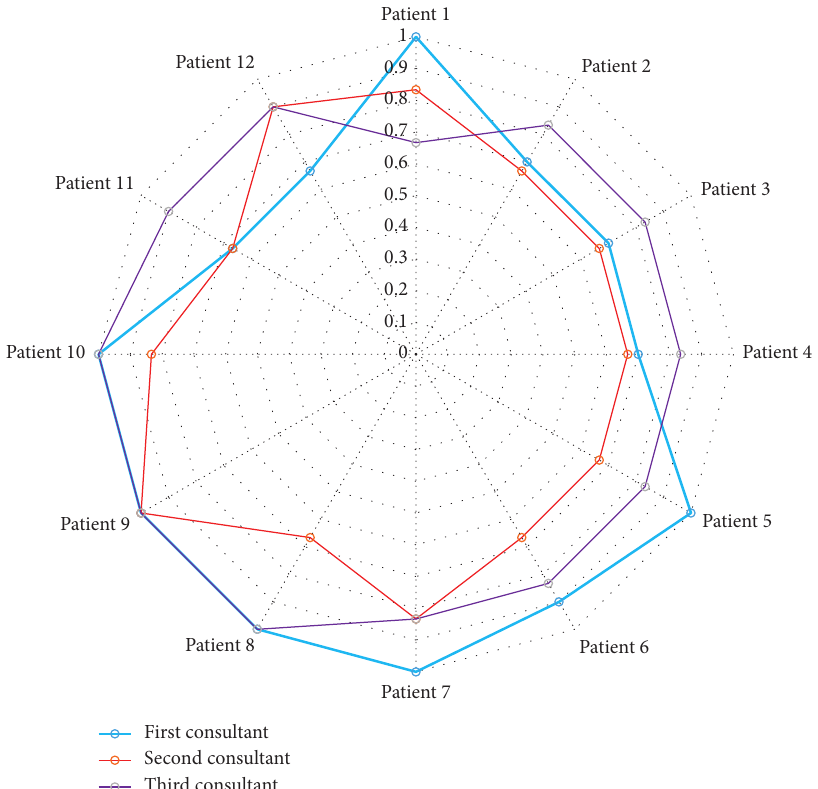
Figure 2: Percent agreement among raters for the twelve patients evaluated by the consultants in terms of complication